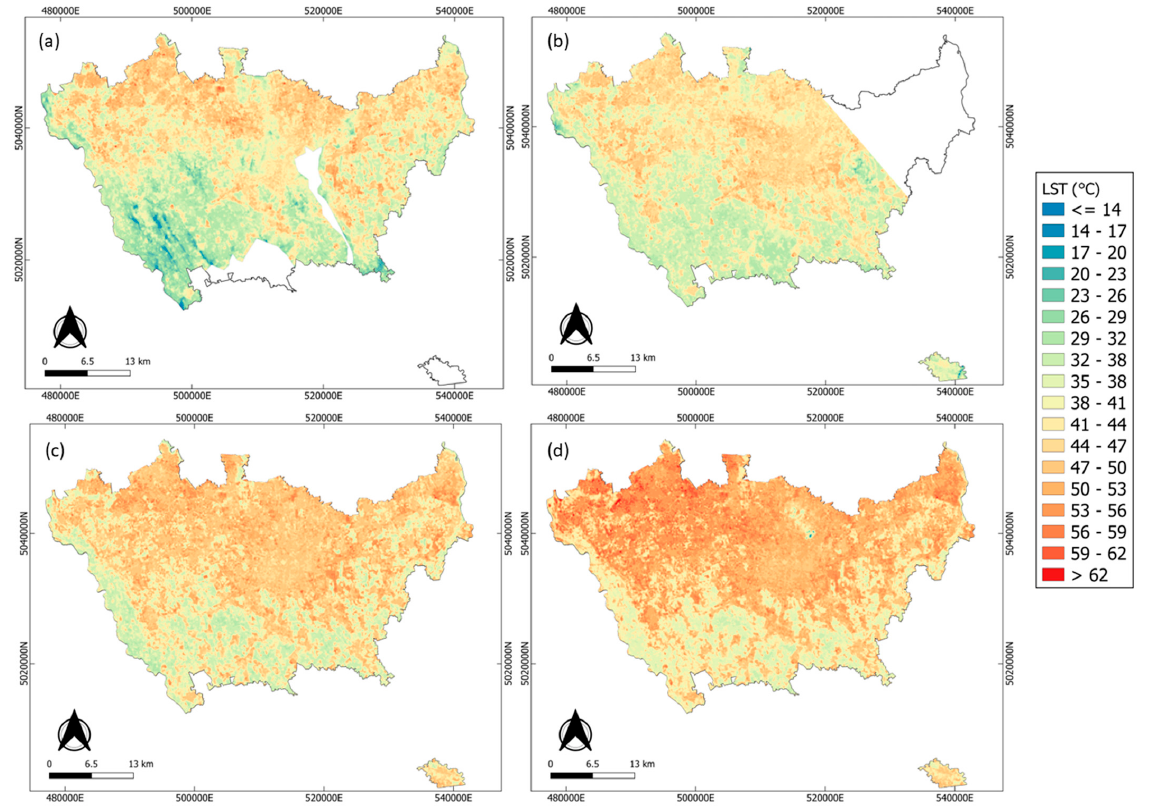
Figure 8. LST maps computed from Landsat 8 imagery relative to: ( a ) 6 July 2021; ( b ) 22 July 2021; ( c ) 17 July 2022; ( d ) 9 July 2022. Cloud-contaminated pixels are removed from the maps. CRS: WGS84/UTM zone 32N.